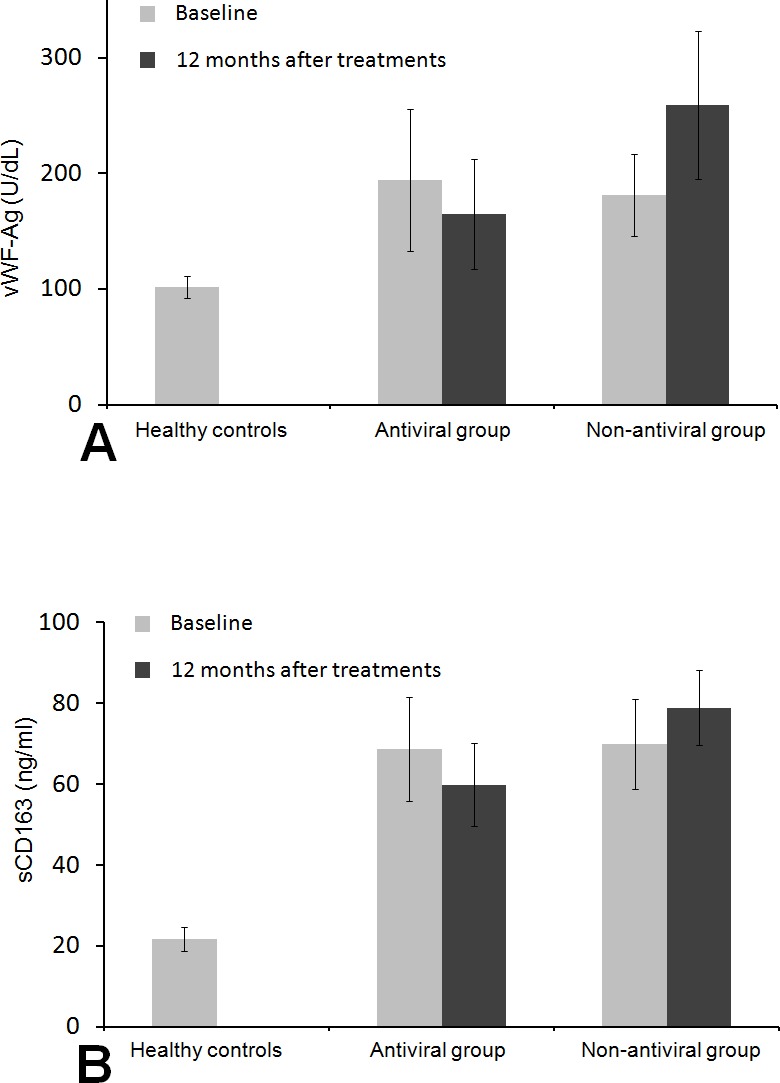
Histogram of levels of peripheral vWF-Ag and sCD16 in patients and healthy control subjects.Comparisons of vWF-Ag (A) and sCD163 (B) among different groups at baseline and at 12 months after the treatment. vWF-Ag and sCD163 were significantly higher in patients with antiviral therapy and non-antiviral therapy than those in healthy controls. The histograms represent mean value. *P < 0.05 compared to Non-antiviral group and Antiviral group. **P > 0.05 Non-antiviral group compared to Antiviral group.